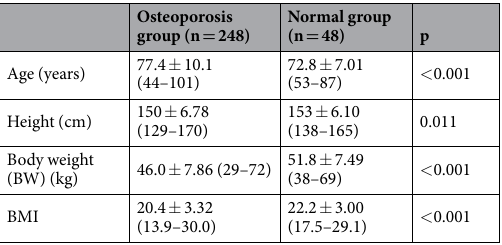
Table 2. Characteristics of patients in osteoporosis and normal groups.